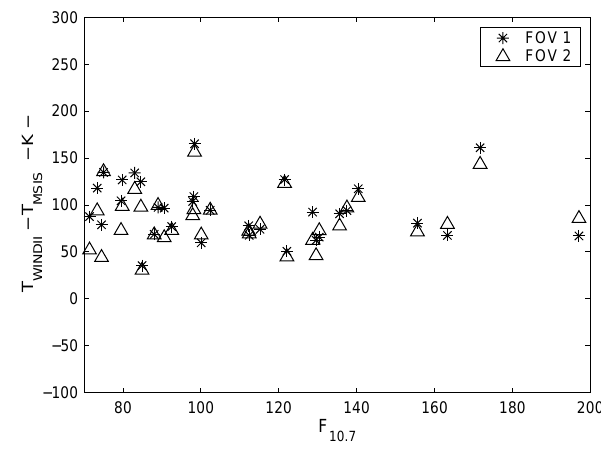
Fig. 9. Differences between the mean daily temperatures observed by WINDII and given by the MSIS-90 empirical model for the quiet days as a function of the solar